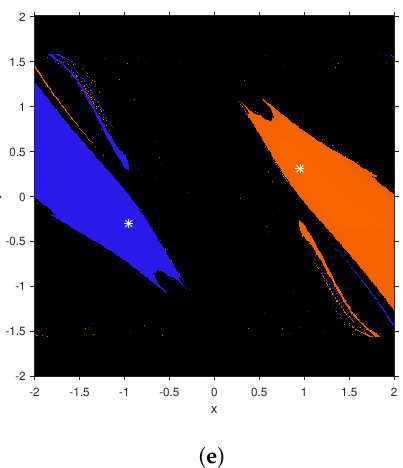
Figure 1. Basins of attraction of known and proposed methods on F ( x 1 , x 2 ) = 0. ( a ) H 6,1 ; ( b ) H 6,2 ; ( c ) H 6,3 ; ( d ) H 6,4 ; ( e ) H 9,1 .